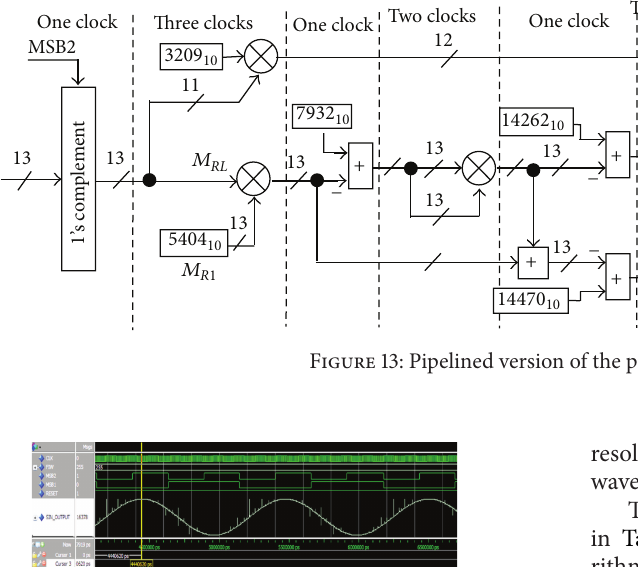
Figure 14: ModelSim Gate level simulation result.